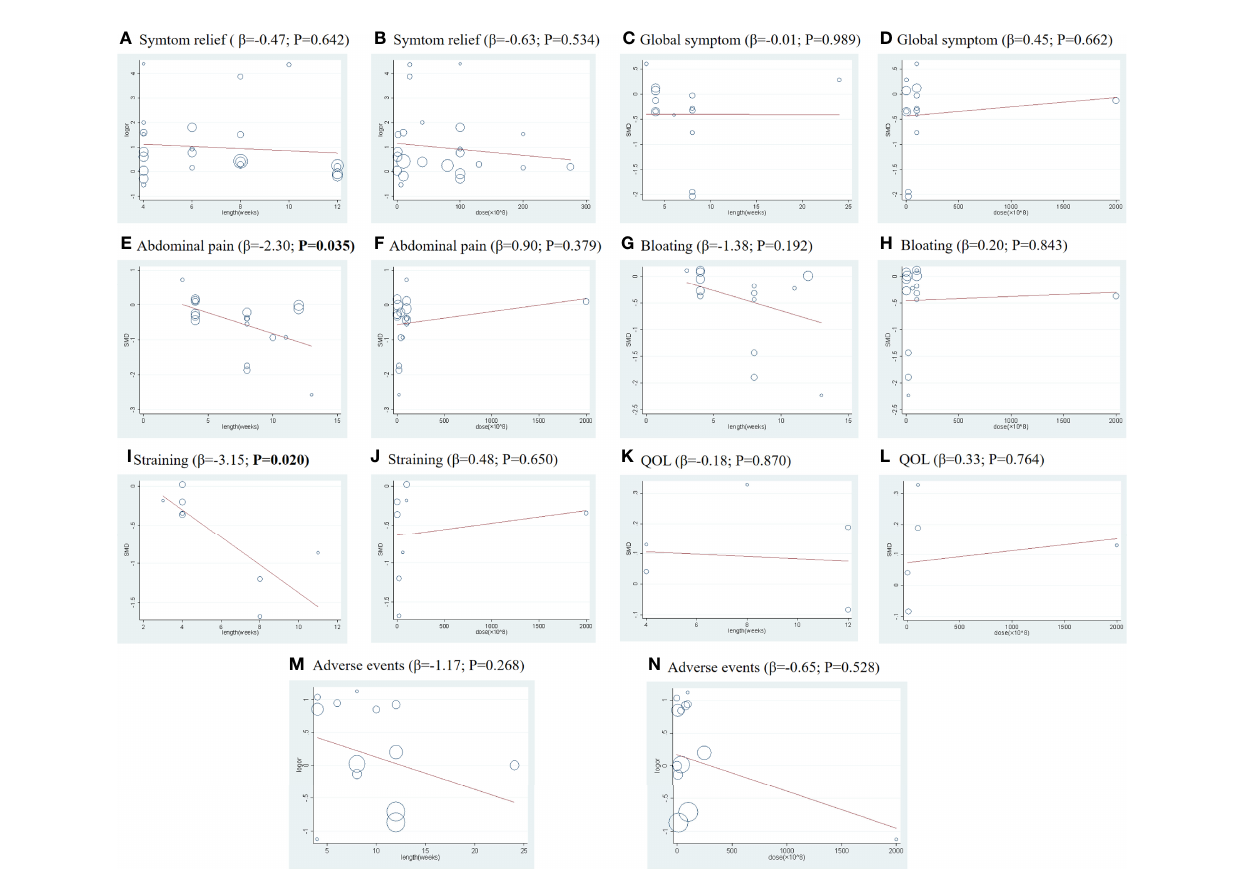
FIGURE 3 | Meta-regression by treatment lengths and doses for all primary and secondary outcomes: (A, C, E, G, I, K, M) indicate the meta-regression analysis by treatment lengths for the outcomes of symptom relief rate, global symptom score, abdominal pain score, bloating score, straining scores, QOL, and adverse events, respectively; (B, D, F, H, J, L, N) indicate the meta-regression analysis by doses for the outcomes of symptom relief rate, global symptom score, abdominal pain score, bloating score, straining scores, QOL, and adverse events, respectively. The abscissa (X) represents the duration (weeks) or dose (×108), and the ordinate (Y) represents the